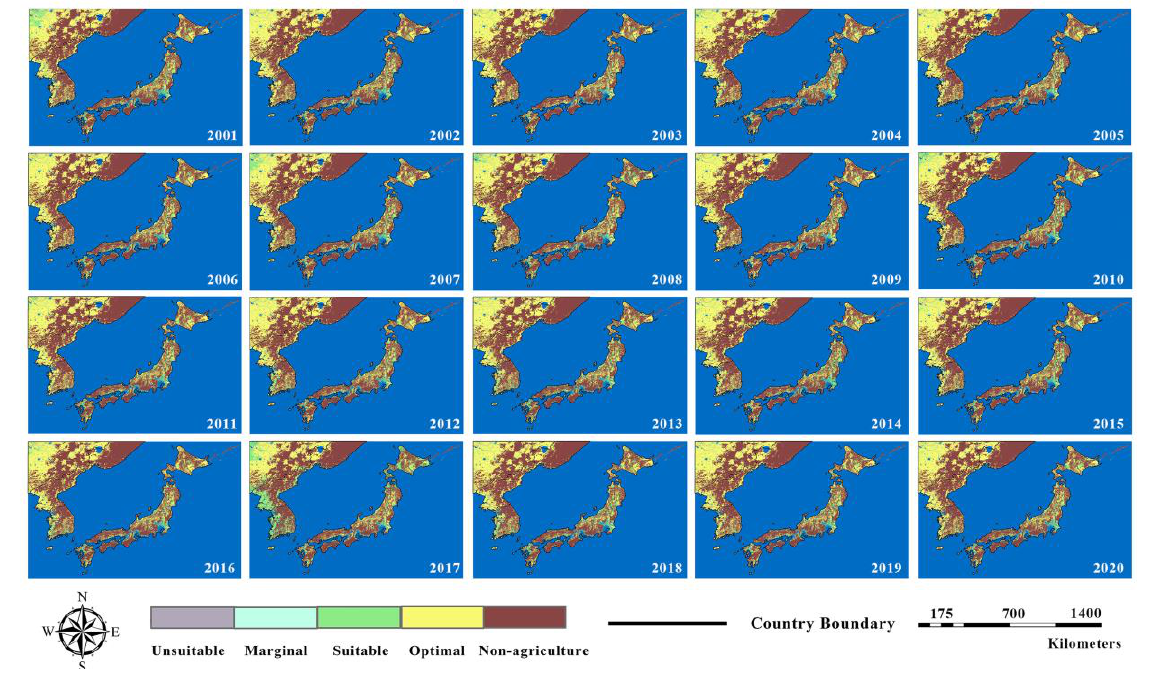
Figure 4. Bio-geophysical suitability maps of East Asia from 2001 to 2020 in summer.